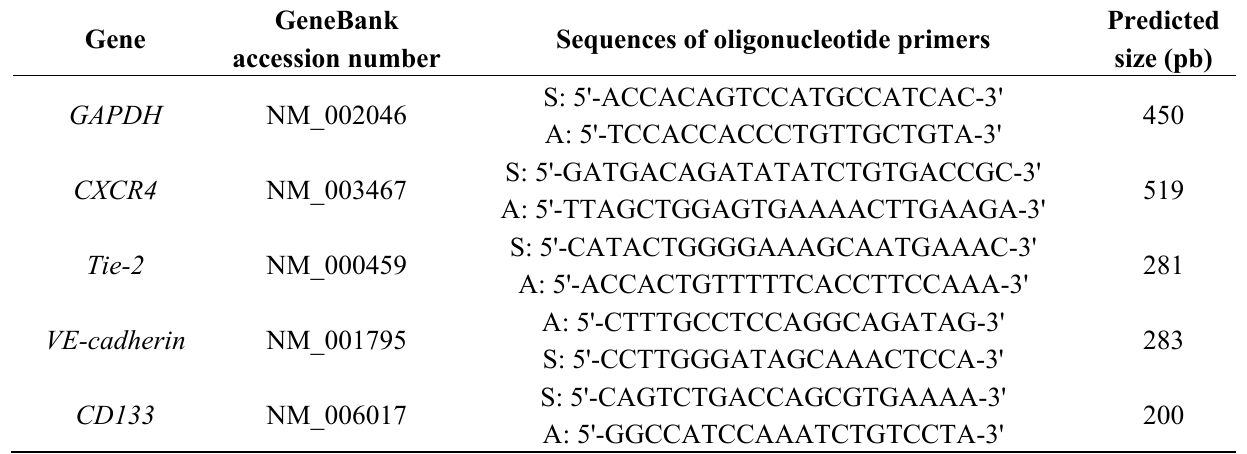
Table 1. Sequences of the oligonucleotide primers (Metabion, Martinsried, DE) used for